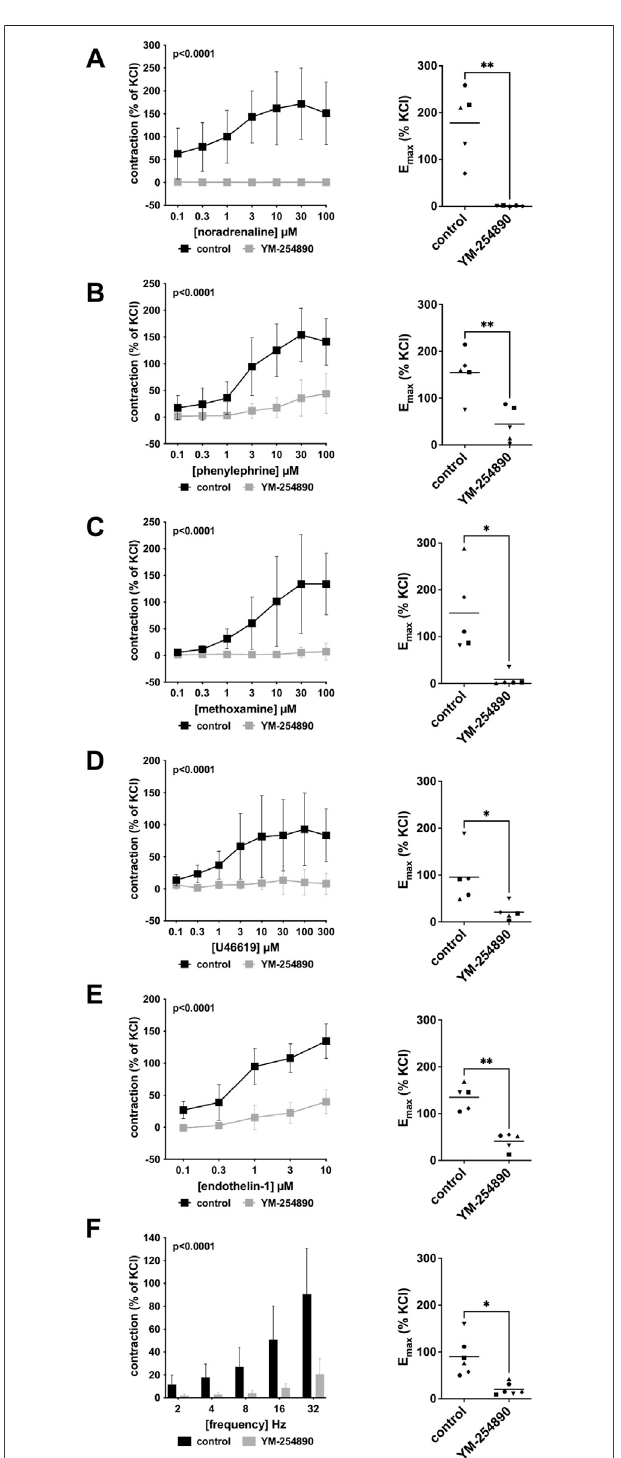
FIGURE 2 | Effects YM-254890 on adrenergic and non-adrenergic, and EFS-induced neurogenic contractions of human prostate tissues. Adrenergic contractions were induced by the α 1-adrenoceptor agonists noradrenaline (A) , phenylephrine (B) , and methoxamine (C) , while non-adrenergic contractions were induced by thromboxane A2 analog U46619 (D) and